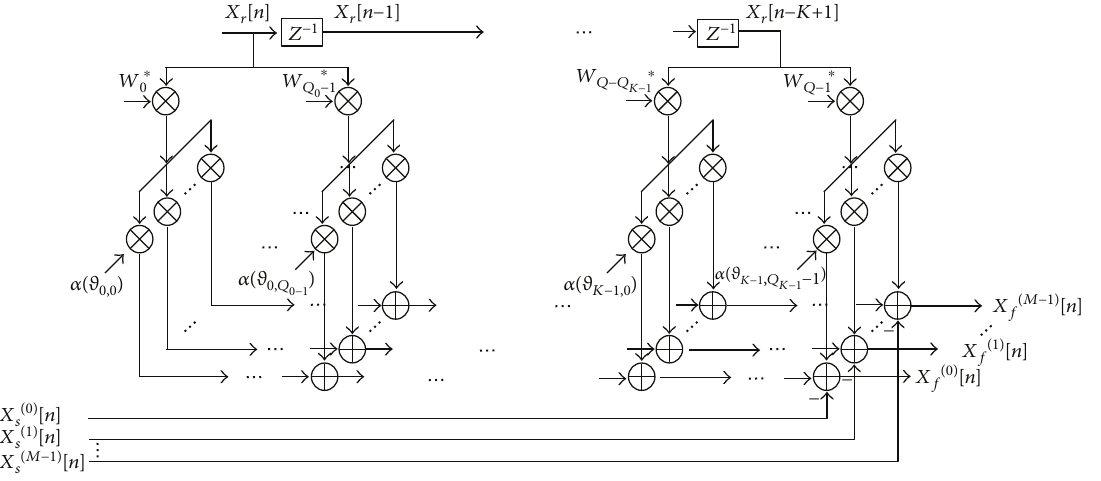
Figure 4: Structure of the proposed interference canceller fi lter